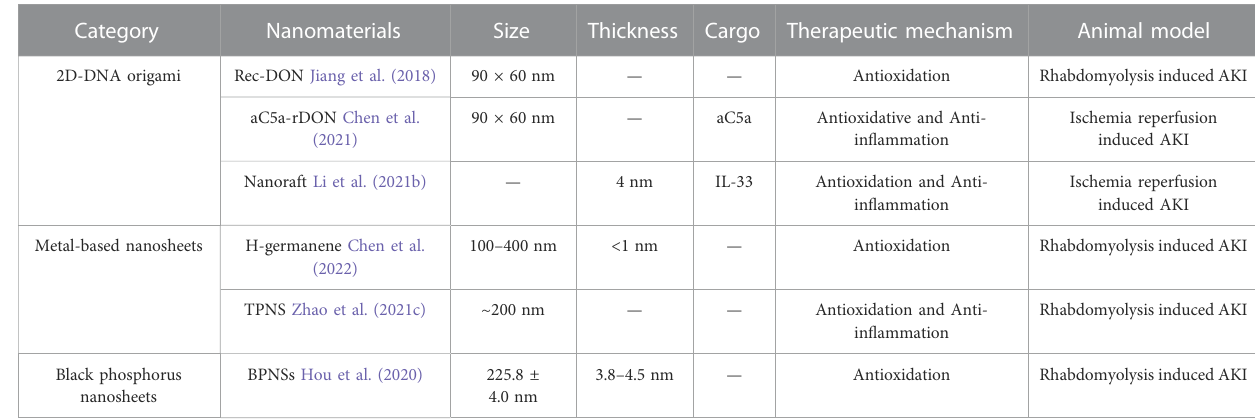
TABLE 1 2D-nanomaterials in AKI